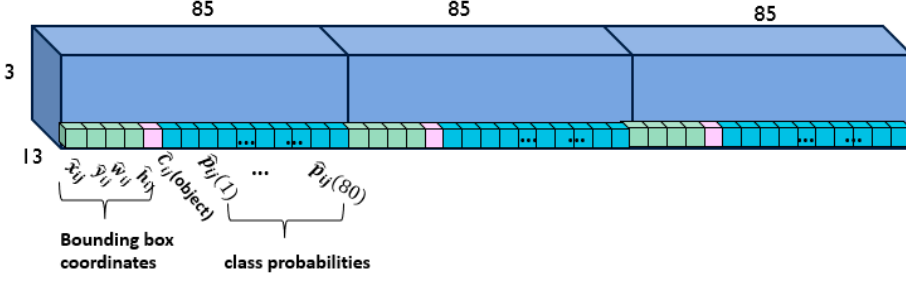
Figure 3. The 13 × 13 × (85 × 3) output layer in YOLOv3.